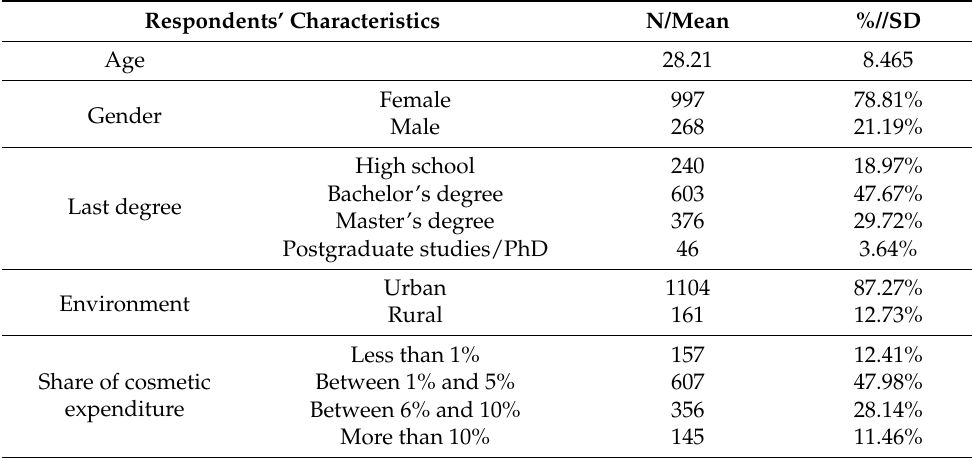
Table 2. Demographic characteristics of the